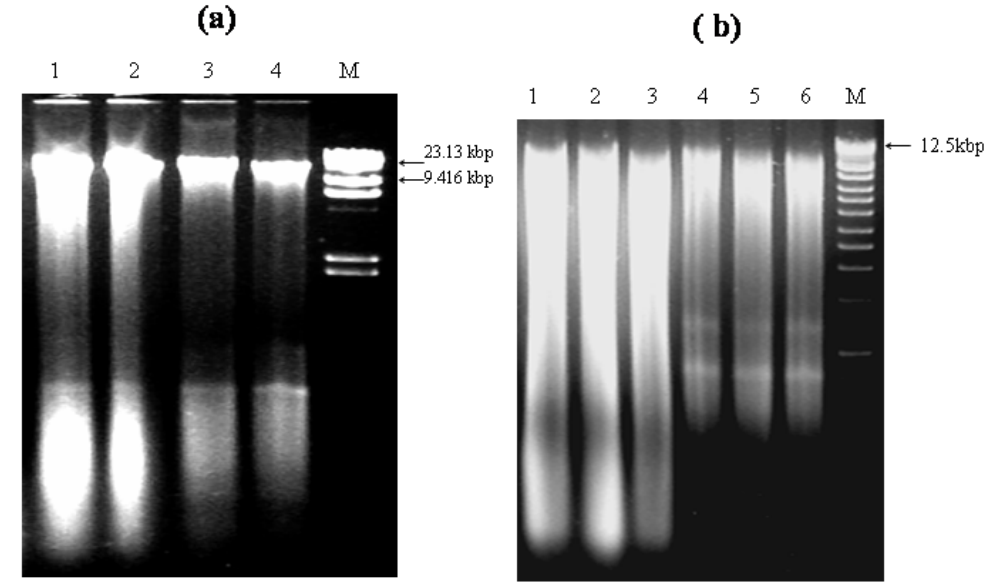
Figure 1. Integrity and molecular size of extracted ATAD DNA by two extraction methods as visualized by agarose gel electrophoresis: (a) commercial MoBIO kit from ATAD Reactor 1A (a, Lanes 1 − 2) and ATAD Reactor 2A (a, Lanes, 3 − 4) and (b) by solvent-based method. ATAD Reactor 1A (b, Lanes 1 − 3) and ATAD Reactor 2A ( b , lanes 4 − 6). (a) M, λ  DNA/ Hin d III molecular weight marker (Invitrogen) (a) and (b) M, 1 kb DNA Ladder (Invitrogen) were used as recommended by